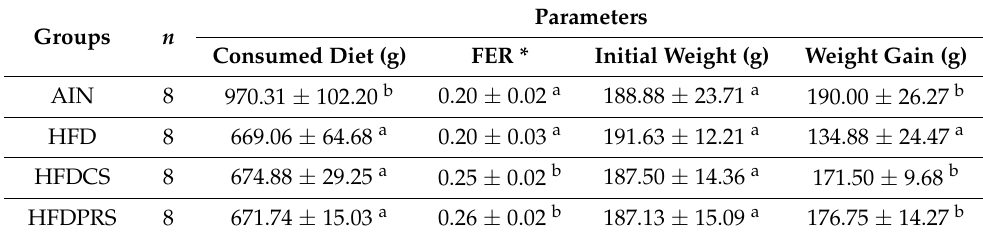
Table 1. Selected general nutritional parameters of rats on experimental diets. Parameters Groups n Consumed Diet (g) FER * Initial Weight (g) Weight Gain